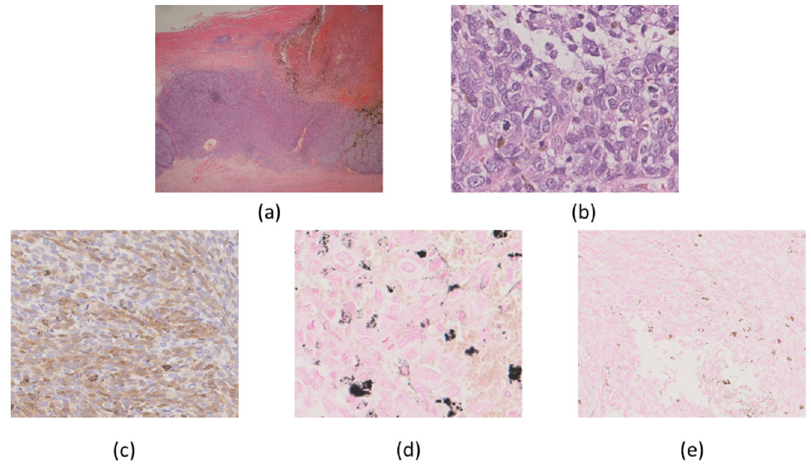
Figure 4. Fibrotic wall showing scattered pigmented areas ( a : 2 × ). Tumor cells consisted of enlarged nuclei and melanin granules ( b : 20 × ). Immunohistochemically, tumor cells were positive for MelanA ( c : 10 × ). The granules were positive for Fontana-Masson ( d : 20 × ), and negative for collioid iron staining ( e : 10 × ).